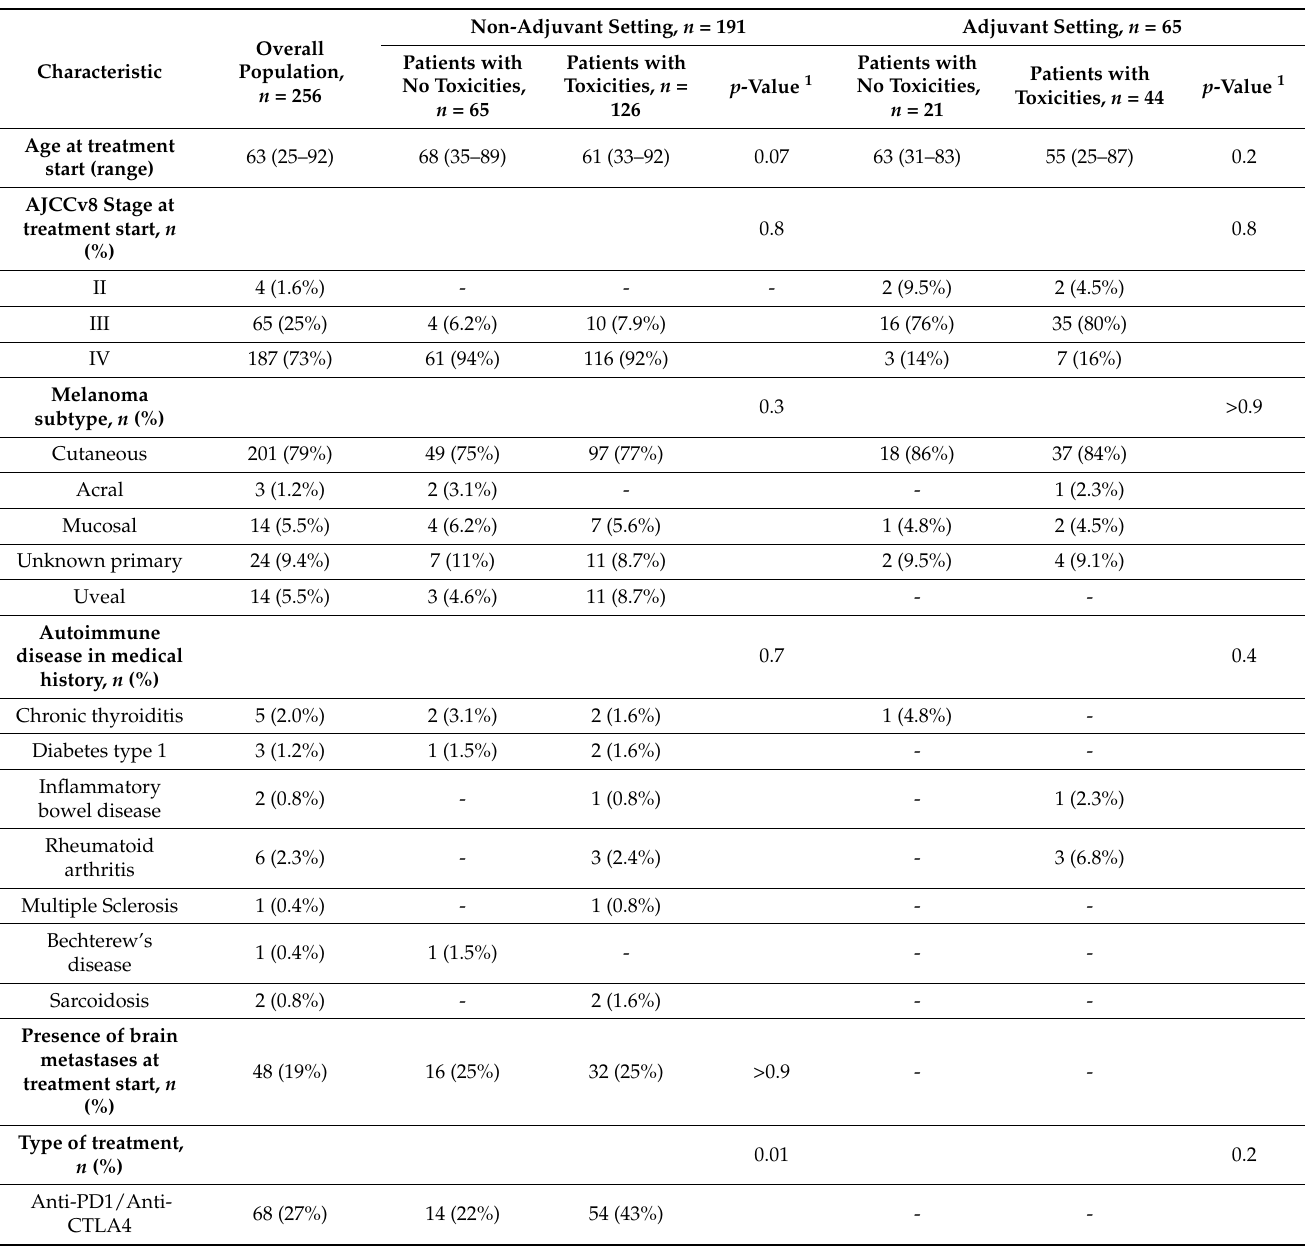
Table 1. Patients’ characteristics in the overall population, non-adjuvant and adjuvant